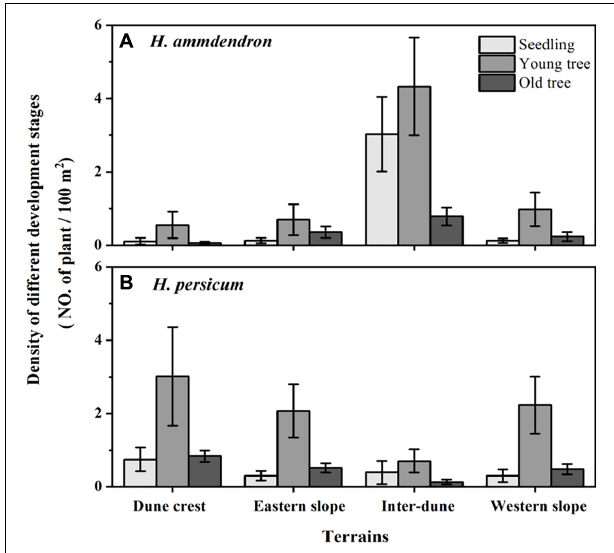
FIGURE 4 | Density of Haloxylon ammodendron (A) and H. persicum (B) of different development stage at different terrains. Data are presented as the mean ± 1 standard